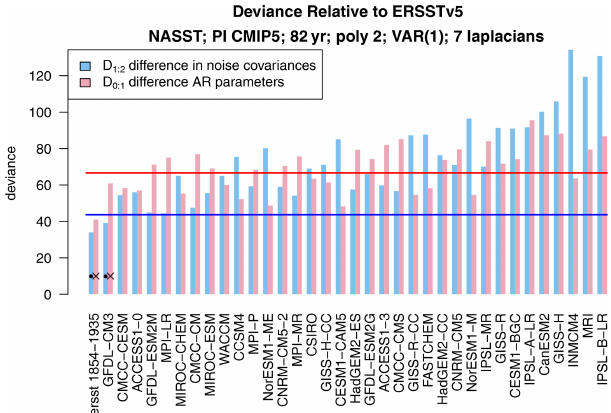
Figure 1. The deviance statistics D 1 : 2 (blue) and D 0 : 1 (red) for comparing ERSSTv5 1854–1935 to 82-year segments from 36 CMIP5 pre-industrial control simulations and to ERSSTv5 1936– 2018. The 5% critical values for D 1 : 2 and D 0 : 1 are indicated by the horizontal blue and red lines, respectively. The dots indicate H 1 is not rejected; i.e., equality of noise covariance matrices is not re- jected.